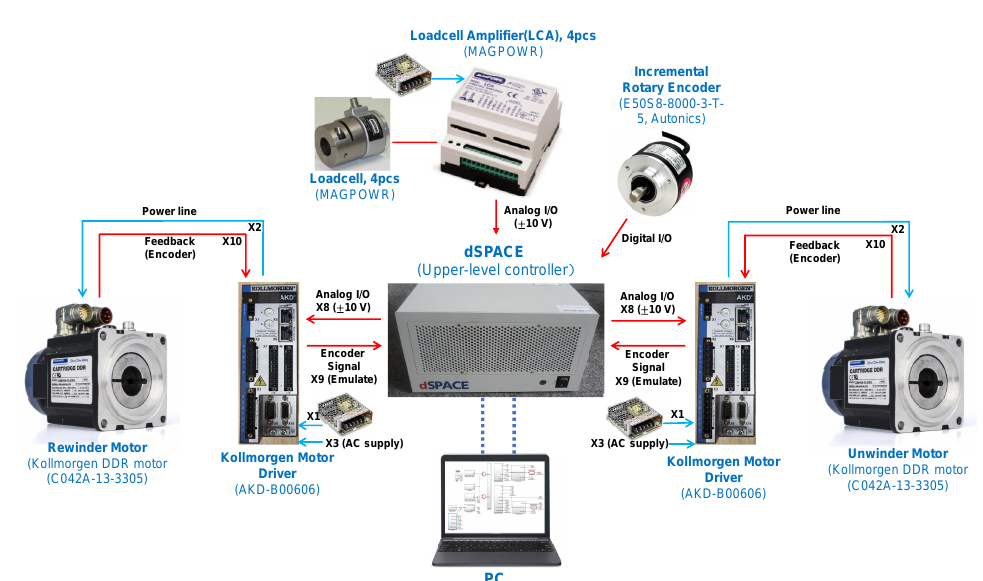
Figure 8. An experimental setup for a high accuracy web transportation of the two-actuator-based R2R